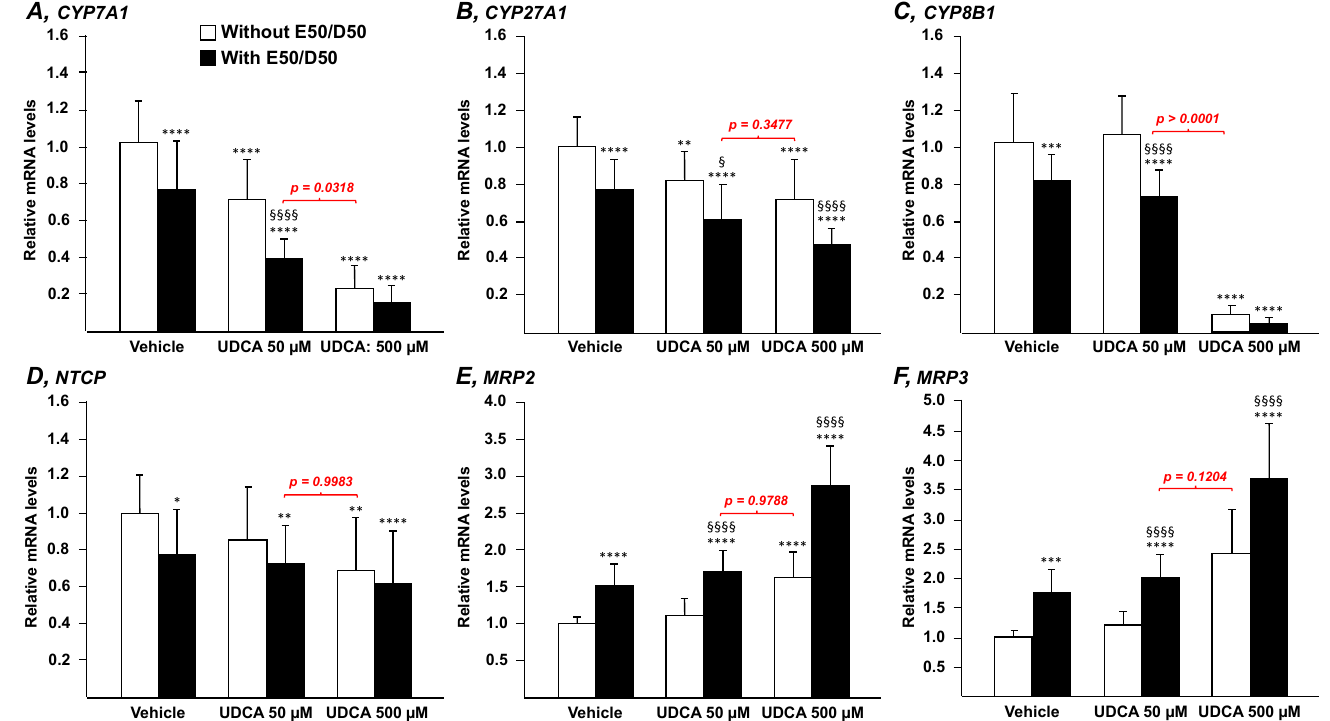
Figure 1. N-3 PUFAs potentiate the effects of UDCA on genes governing bile acid homeostasis. Human hepatoma HepG2 cells were treated with vehicle (DMSO), EPA/DHA (50/50 µM), UDCA (50 or 500 µM) or a combination of EPA/DHA (50/50 µM) and UDCA (50 or 500 µM) for 24 h. Total RNA was extracted. CYP7A1 ( A ), CYP27A1 ( B ), CYP8B1 ( C ), NTCP ( D ), MRP2 ( E ), and MRP3 ( F ) transcript levels were quantified by qRT-PCR as detailed in the materials and methods section, and mRNA levels were expressed relatively to control cells set at 1. Data represent the mean of 3 independent experiments in which each treatment was performed in quadruplicate. Each data point therefore corresponds to the mean of 12 replicates ± SD. Statistical significances as determined by a one-way ANOVA followed by Tukey’s multiple comparison post-hoc were as follows: Vehicle vs. UDCA treated cells: * p < 0.05; ** p < 0.01, *** p < 0.001, **** p < 0.0001; UDCA